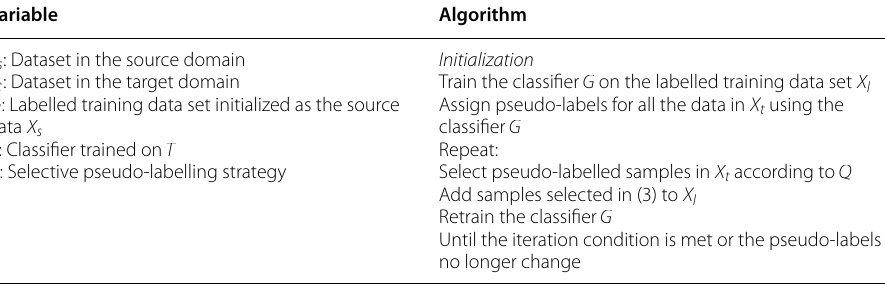
Table 1 Domain adaptation model based on pseudo-labelling Variable